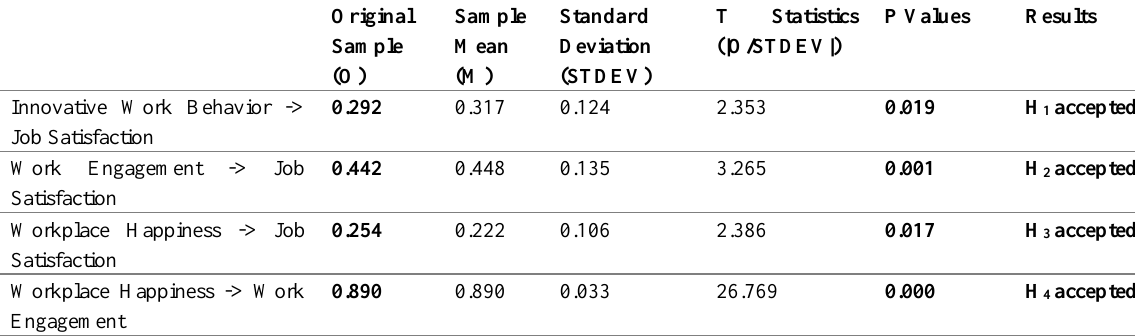
Table 8: Results of Path Coefficients